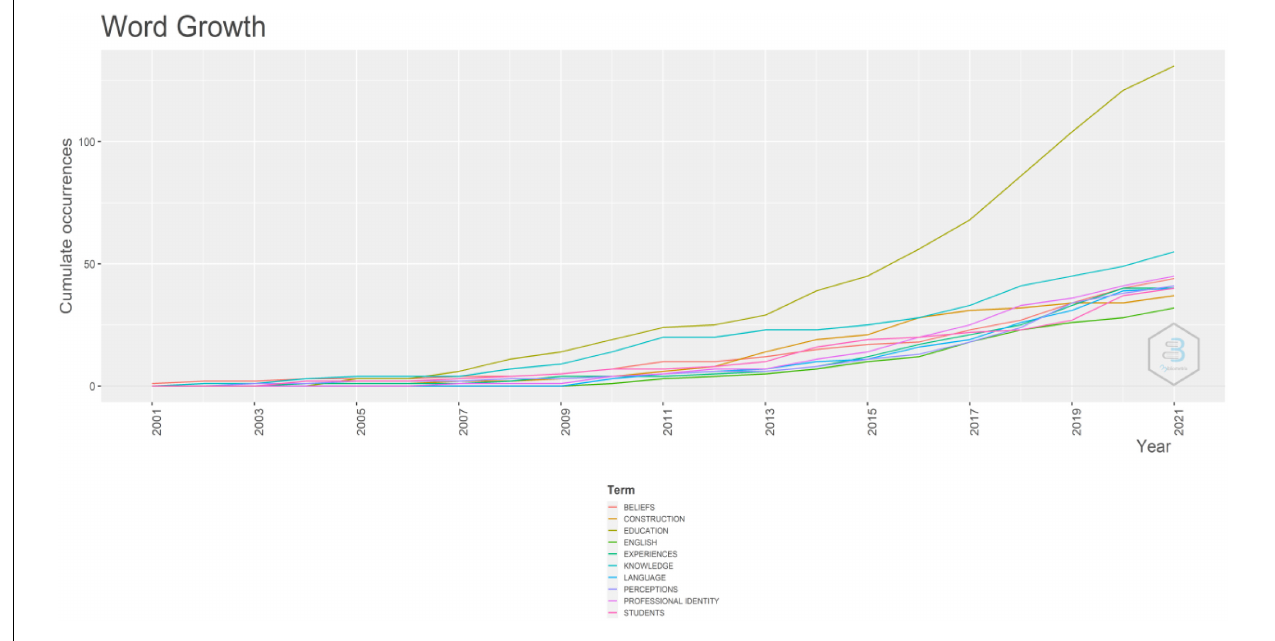
FIGURE 7 | Word growth.